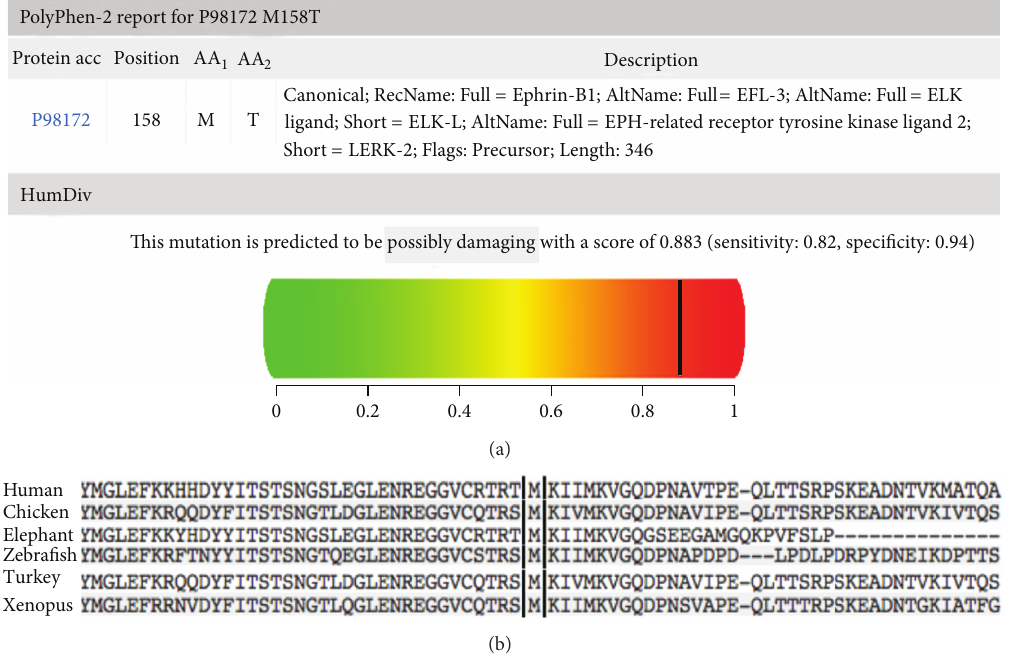
Figure 3: In silico analysis using PolyPhen-2 software shows that change in p.M158T is pathogenic (a) and predicted to be highly conserved in different species